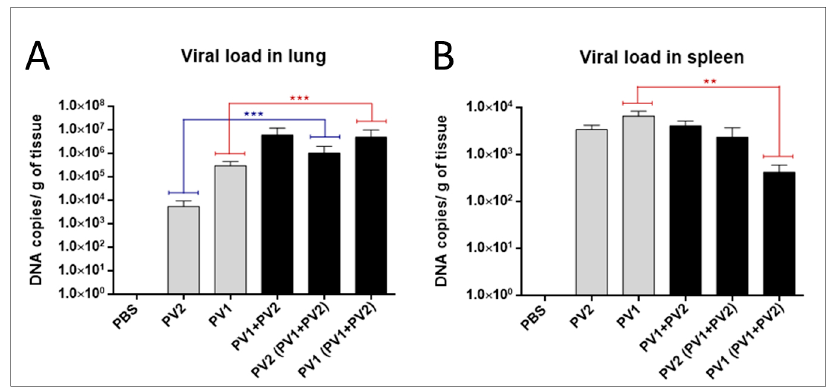
Figure 5. Viral load in mono or coinfected PV1-GII and PV2-GI mice. Viral loads in: lungs ( A ); and spleen ( B ) of Balb/c mice monoinfected (grey columns) and coinfected (black columns) with PV1-GII and PV2-GI were determined by qPCR. Comparisons between mono and coinfected groups are highlighted in red (PV1-GII groups) and blue (PV2-GI groups). The error bars indicate standard deviations. The statistical tests used were One-Way ANOVA and Tukey’s multiple comparisons test Asterisks indicate a statistically significant difference: ** p < 0.01; *** p < 0.001. PV1: Pelotas virus 1; PV2: Pelotas virus 2; PBS: phosphate-buffered saline.